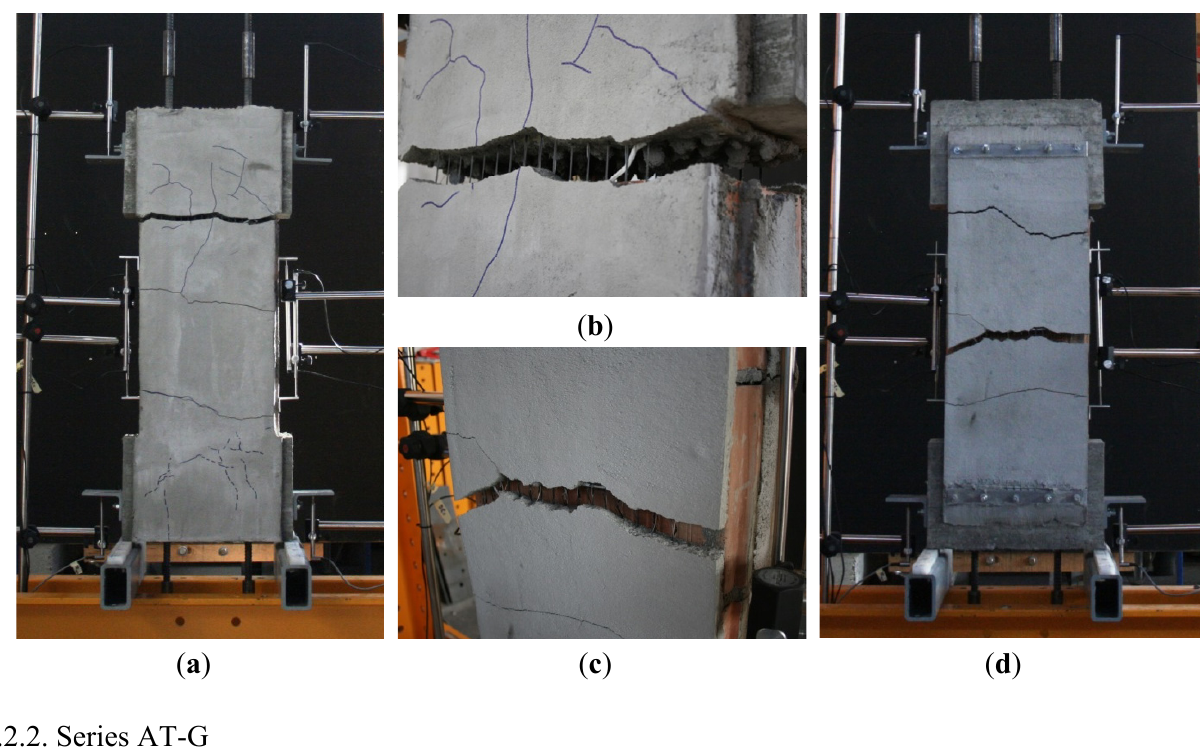
Figure 15. ( a ) Cracking in spray mortar in test AT-F1; ( b ) Failure in test AT-F1; and ( c , d ) Failure in test